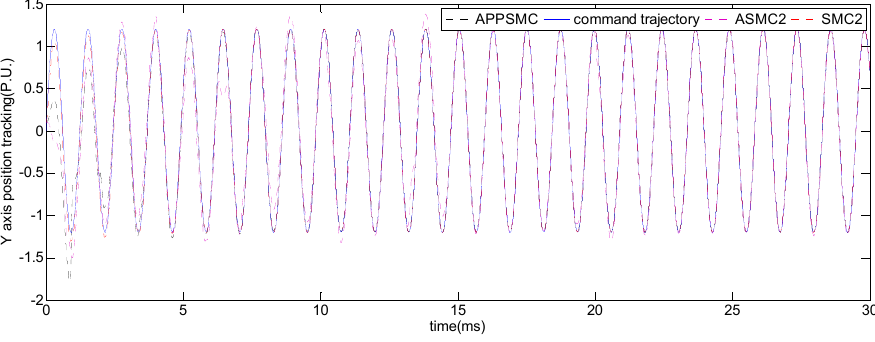
Figure 9. Y axis trajectory tracking comparisons of SMC2, ASMC2, APPSMC.